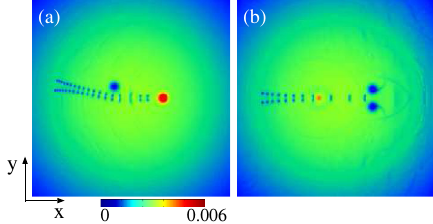
FIG. 11. Stroboscopic images of the column density showing generation and manipulation of a vortex dipole in a 3D trap. (a) A vortex dipole is launched by a red-detuned beam using the method in Fig. 3 and curved using the method in Fig. 9(a). (b) A vortex dipole is launched by a blue-detuned beam using the method in Fig. 6 and decelerated using the method in Fig.